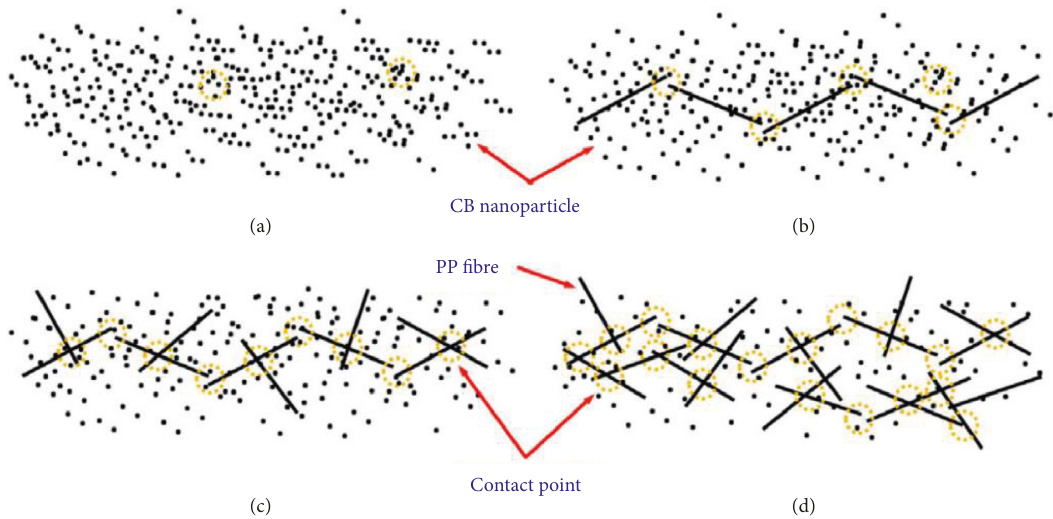
Figure 23: Schematic diagram of CB, PP fibers, and potential contact points in smart concrete. [13].